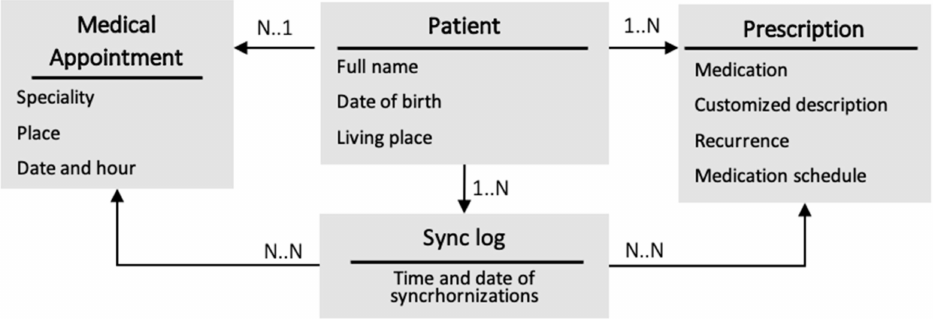
Figure 5. Components of the mobile application